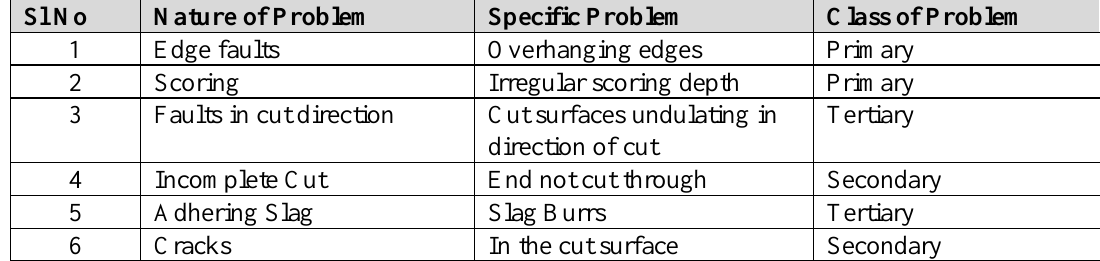
Table 3. “Types of errors in processed